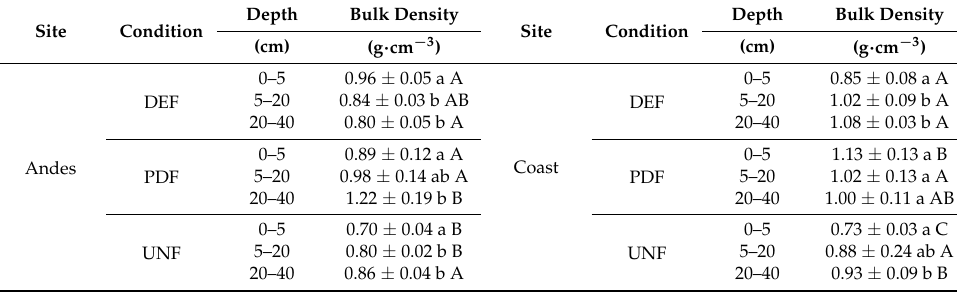
Table 2. Soil bulk density (g · cm − 3 ) of Santa Bárbara soil (Medial, amorphic, mesic Typic Hapludands) and Nahuelbuta soil (very fine, mixed, semiactive, mesic Typic Paleudults) at 0–5, 5–20, and 20–40 cm depths in degraded (DEF), partly-degraded (PDF), and undisturbed (UNF) Nothofagus forests of the Andean and Coastal mountains of south central Chile. Measurements were taken in September 2013 (average ± standard